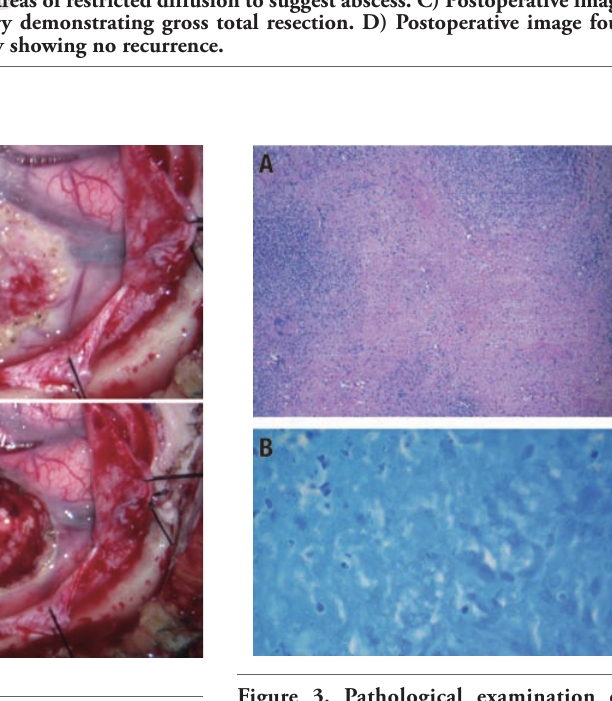
Figure 2. Intraoperative images of tumor. A) Superficial mass with well defined mar- gins and surrounding normal brain tissue; B) resection cavity.